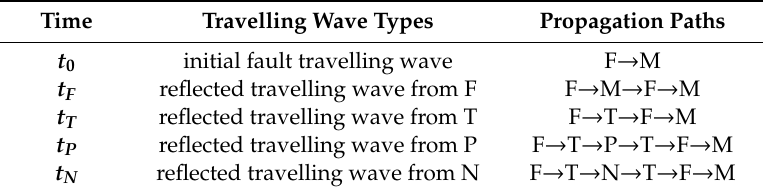
Table 2. Travelling wave types with their reach